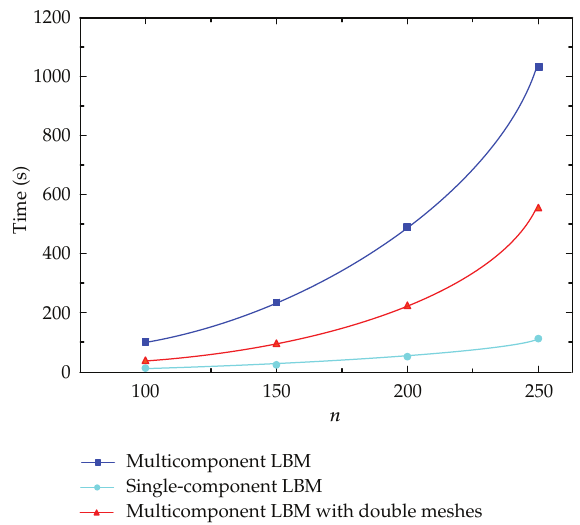
Figure 4: The relation between computation time and grid